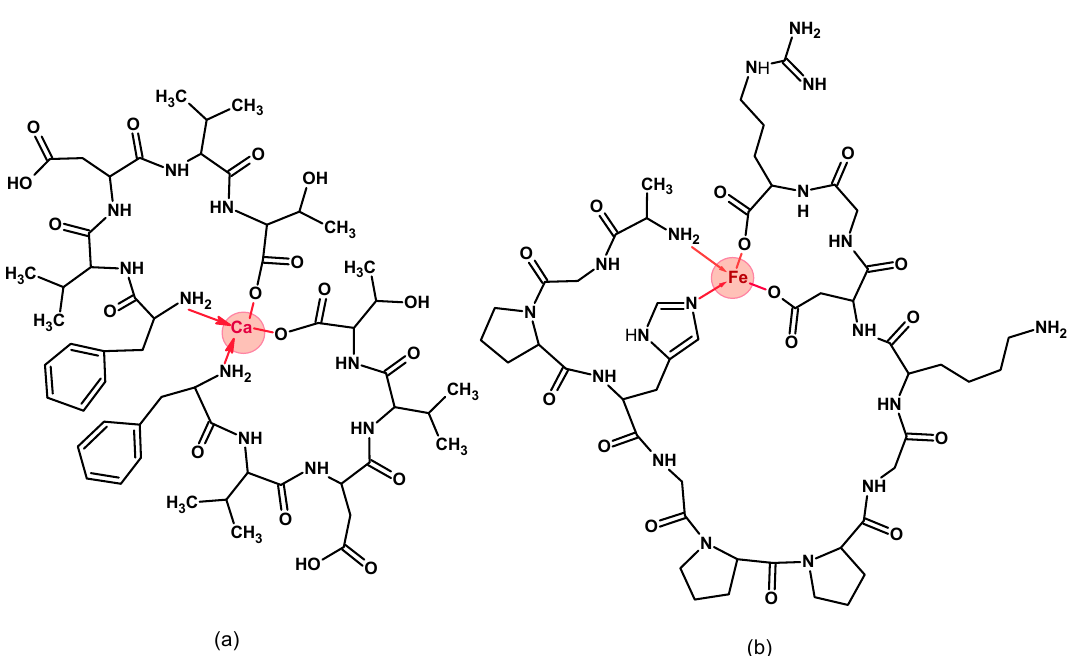
Figure 1. Possible calcium-binding structure for the peptide FVDVT ( a ) and iron-binding structure for the peptide AGPHGPPGKDGR ( b ).